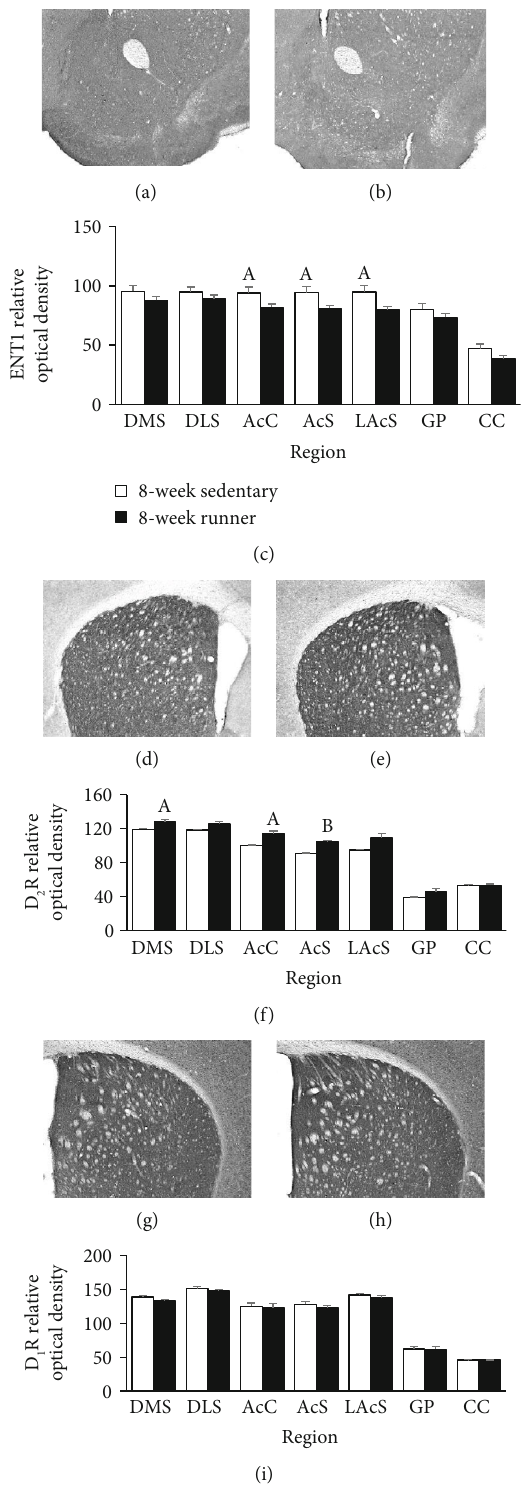
Figure 2: Striatal ENT1, D R, and D R protein expression following eight weeks of wheel running. Representative immunohistochemistry 2 1 images for ENT1 in the mouse striatum following eight weeks of (a) sedentary conditions and (b) running wheel access. (c) Relative levels of ENT1 protein density represented as averages across sections as detailed in Methods. Representative immunohistochemistry images for D R in the mouse striatum following eight weeks of (d) sedentary conditions and (e) running wheel access. (f) Relative levels of D 2 protein density represented as averages across sections detailed in Methods. Representative immunohistochemistry images for D mouse striatum following eight weeks of (g) sedentary conditions and (h) running wheel access. (i) Relative levels of D represented as averages across sections as detailed in Methods. Sedentary 8 weeks vs. runner 8 weeks at A p < 0 : 05 and B p < 0 : 01